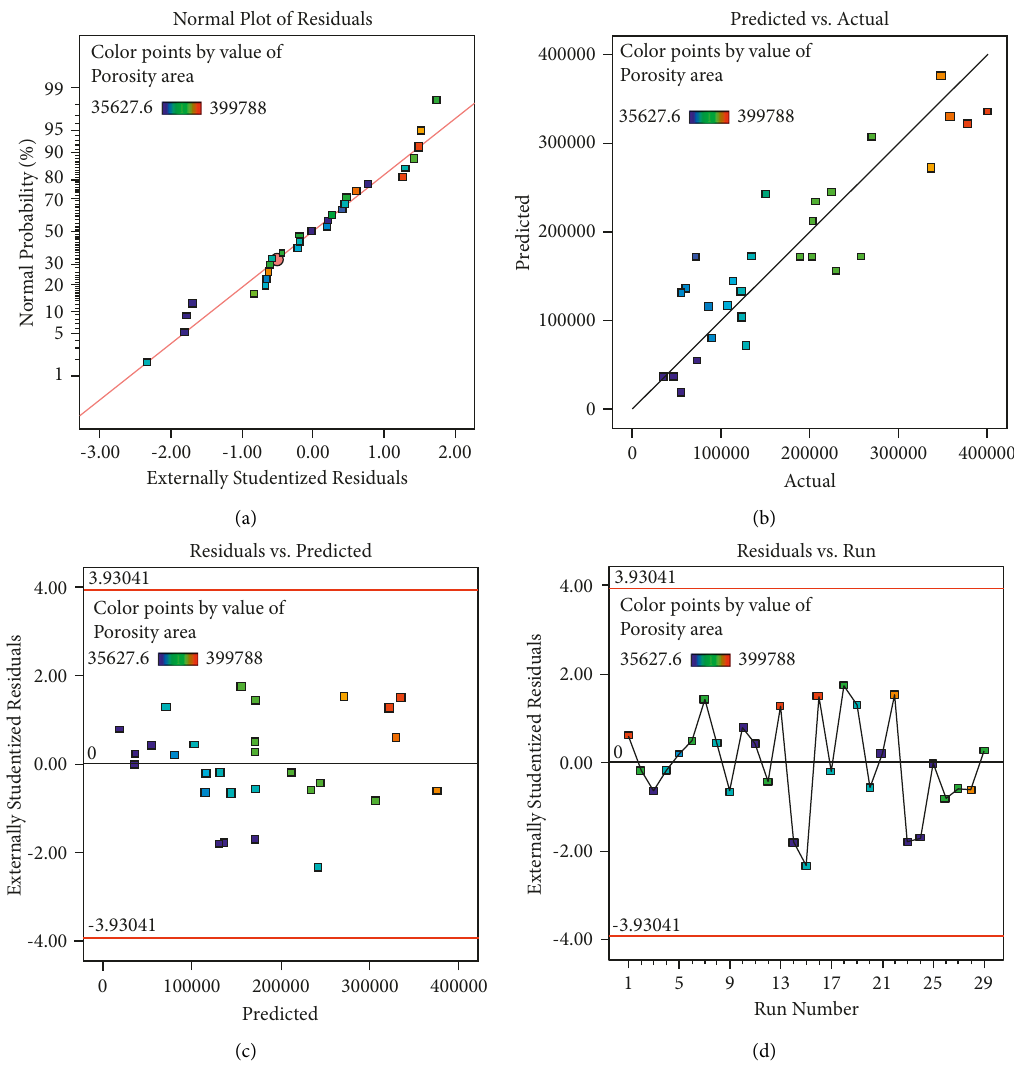
Figure 4: Diagnostic diagram of the porosity area model: (a) the normal distribution of the residuals; (b) projected and actual values; (c) predicted values and residuals; (d) serial number and